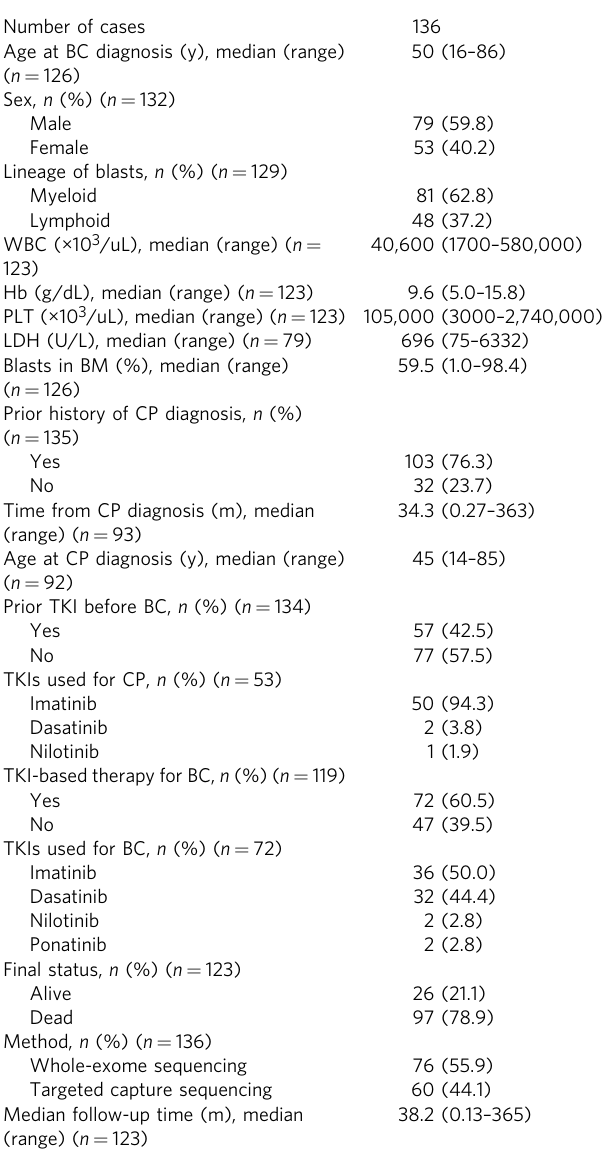
Table 1 Characteristics of patients with